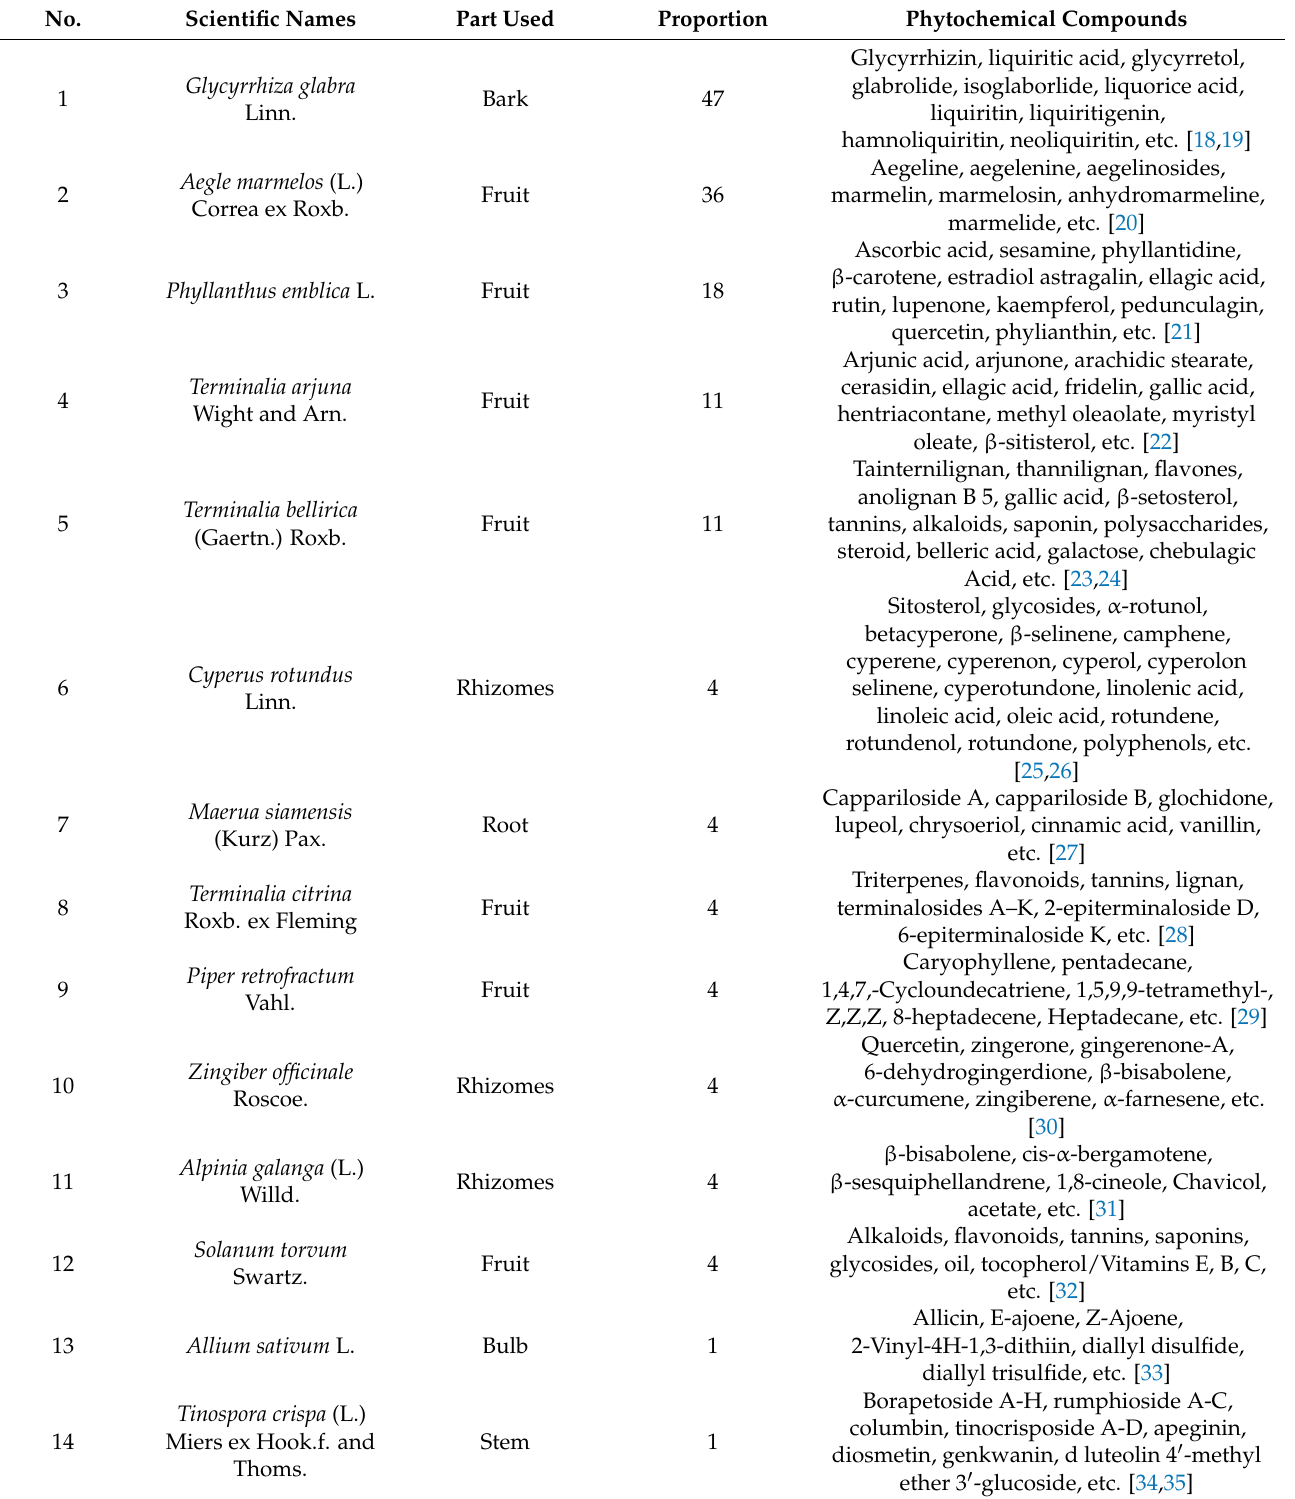
Table 1. Medicinal components of the traditional Thai polyherbal drug Phy-Blica-D (per 150 g formulation) and its phytochemical